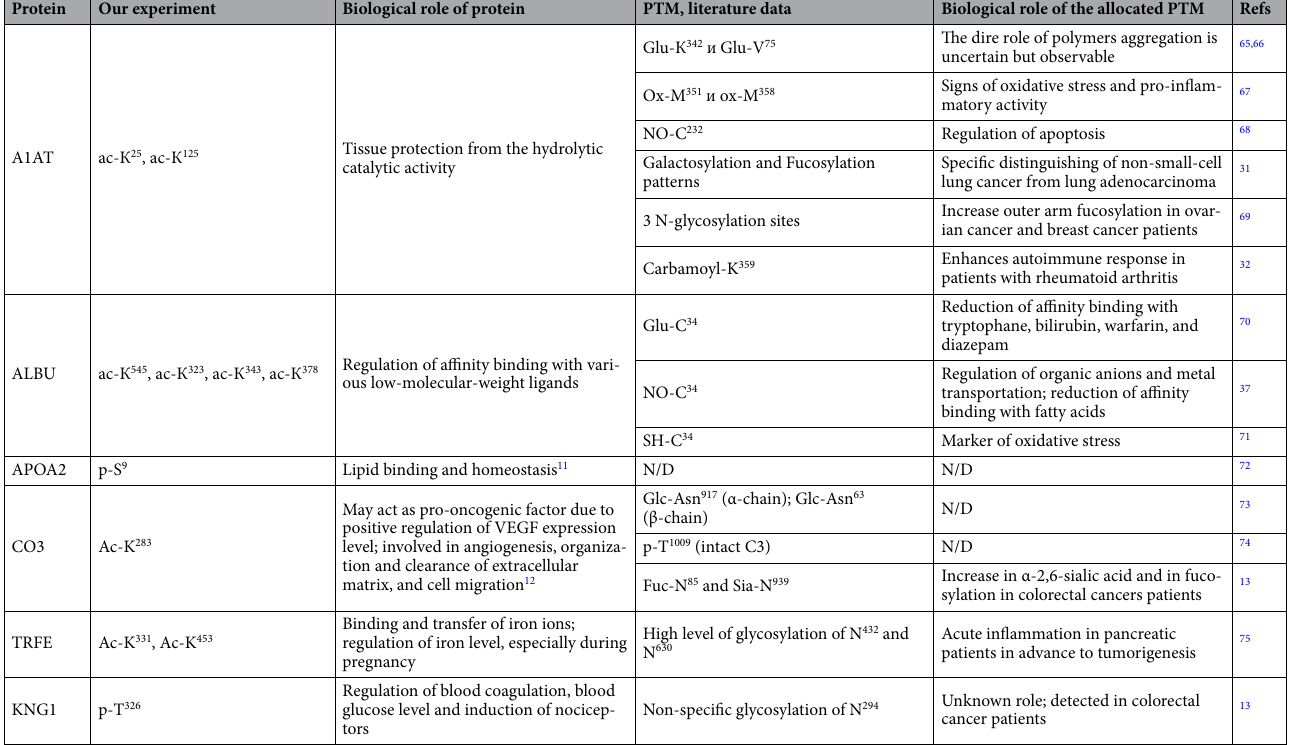
Table 3. Functional amendments of proteins under the impact of the selected PTMs reported in the literature and observed in the present